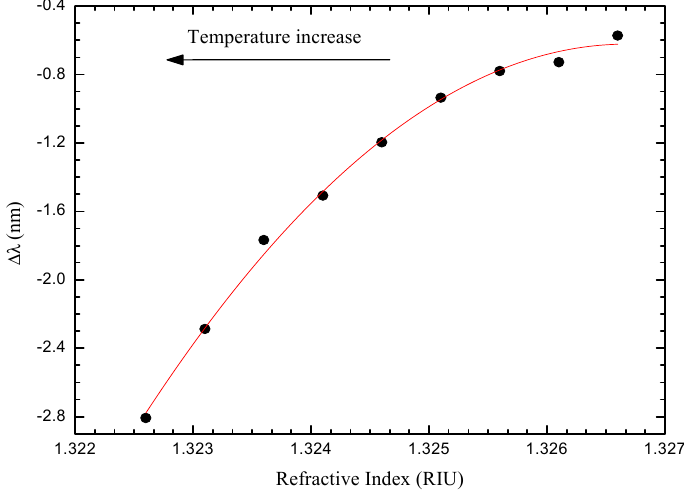
Figure 6. Refractive index response of the sensing head to temperature variations of